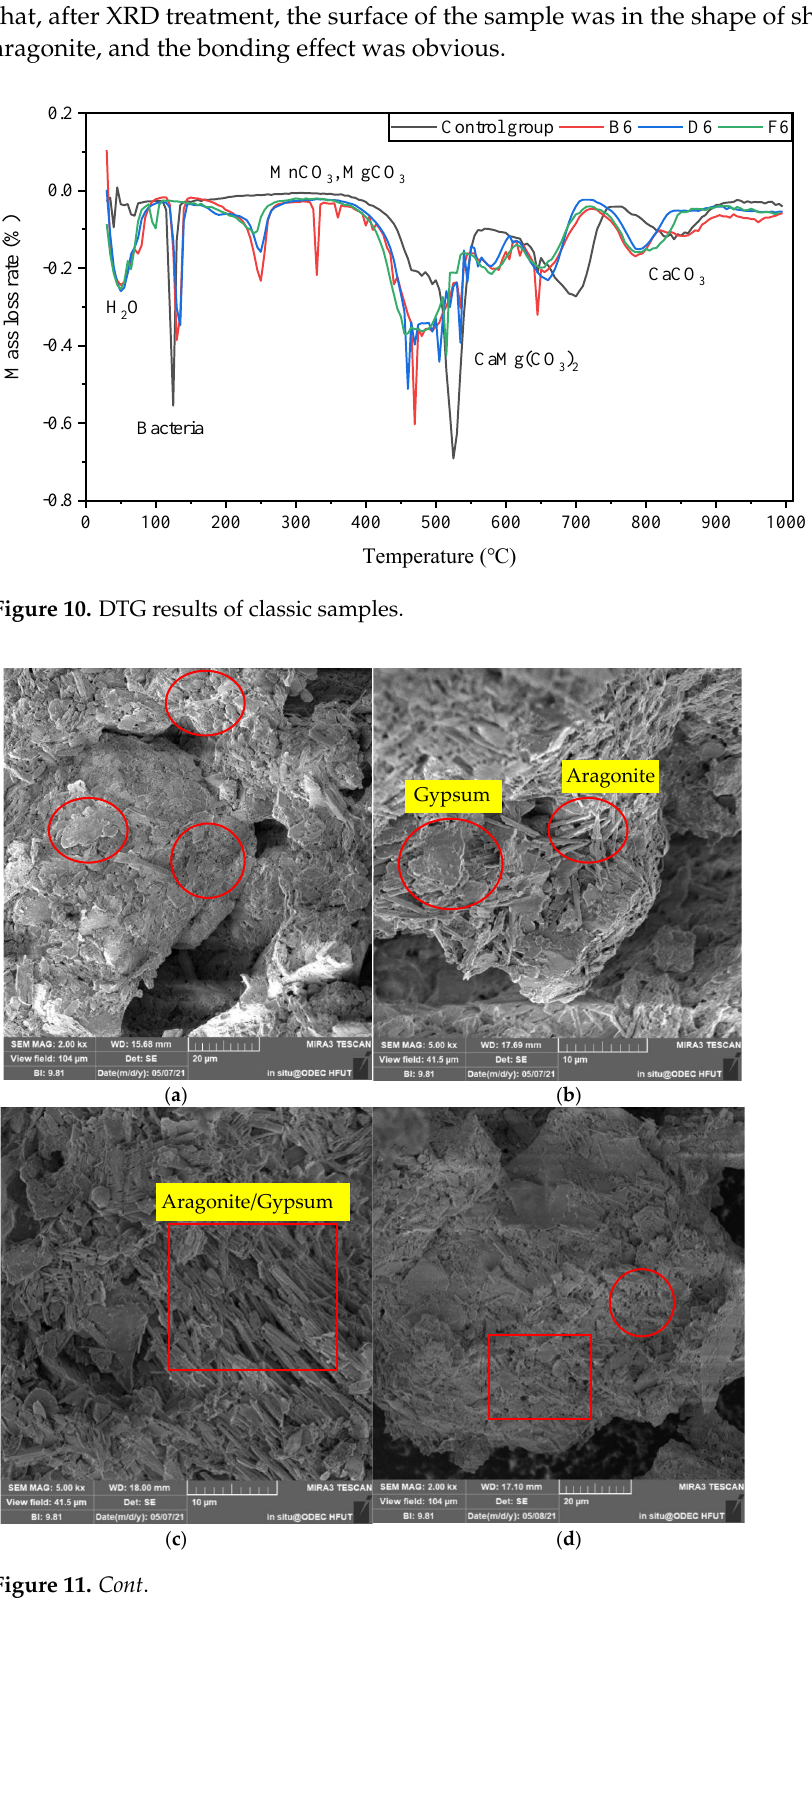
Figure 9. The results of TG.